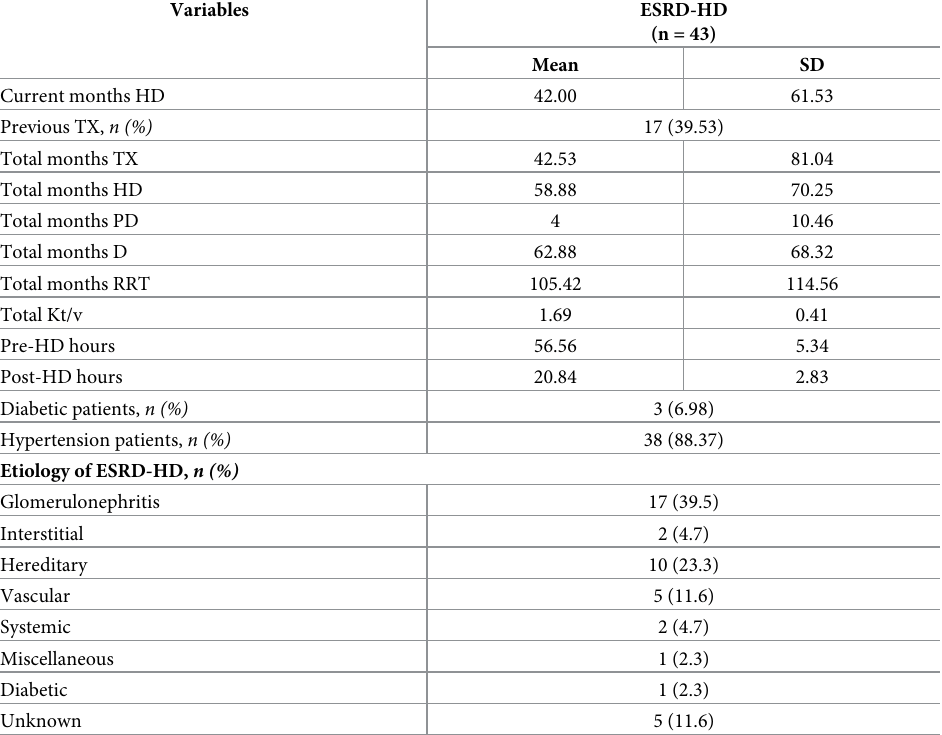
Table 2. Clinical characteristics of the ESRD-HD